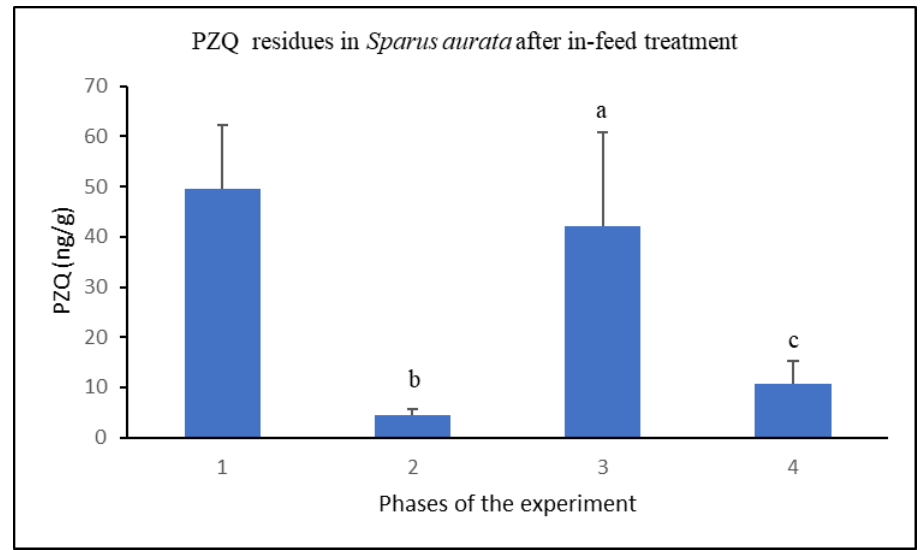
Figure 3. PZQ concentration in Sparus aurata after in-feed treatment. Data are expressed as means ± S.D. for fishes of the different phases of the experimental protocol. Letters indicate significant differences at p < 0.05.